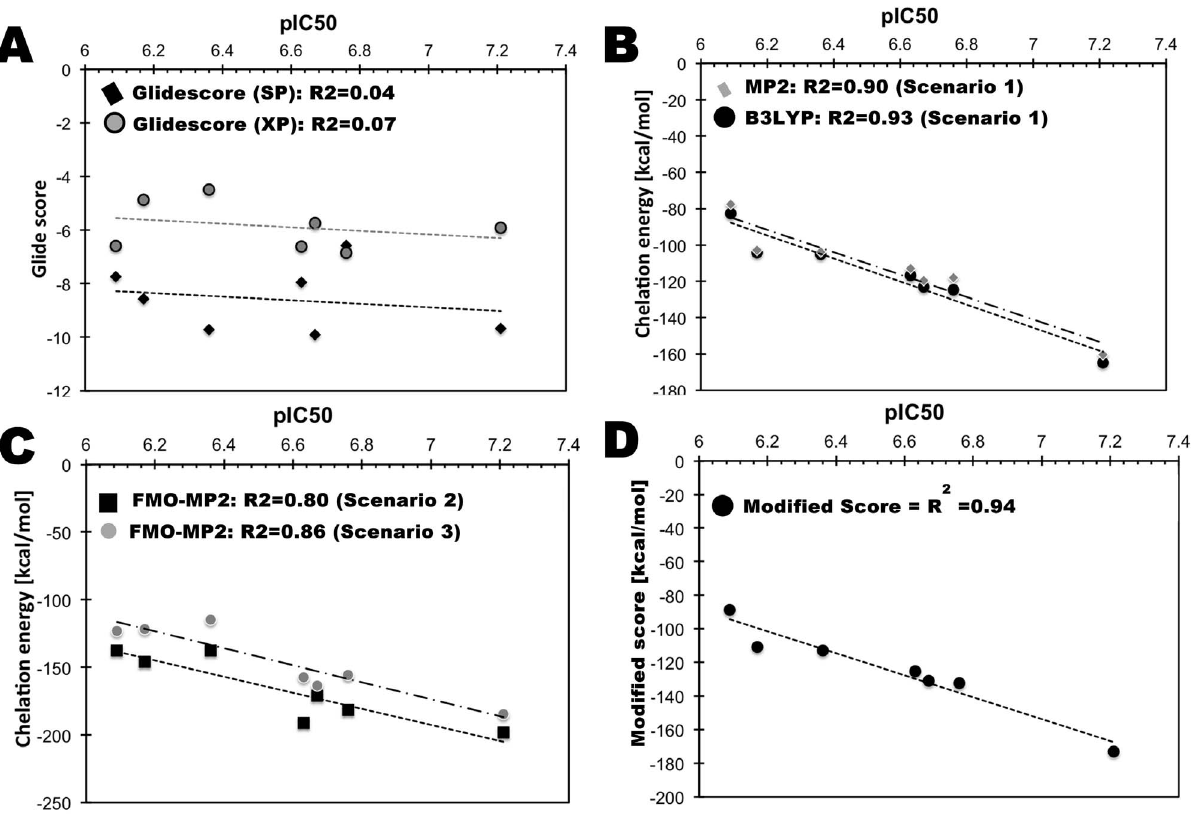
Figure 2. Correlation between observed pIC 50 and predicted binding energy based on the Glide scores (A), scenario 1 (B), scenario 2 and 3 (C), and modified Chelation Score (D).